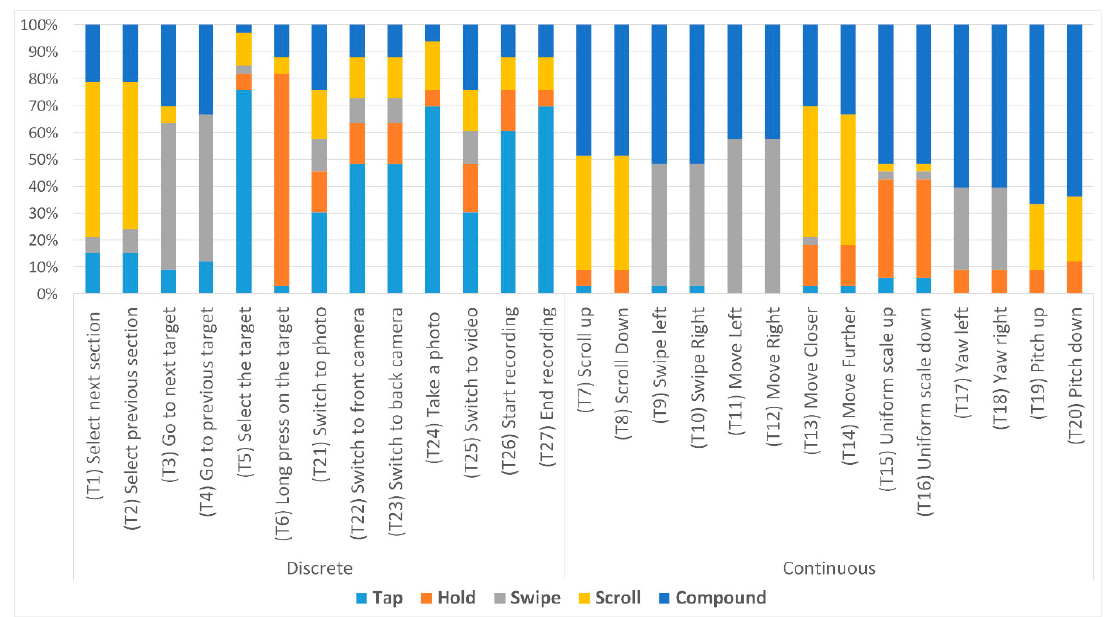
Figure 6. Frequency distribution of action types in the preferred gesture set for 27 tasks. Tap action was highly preferred for the camera tasks.